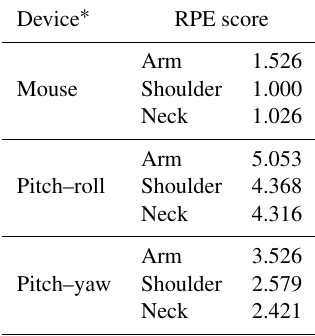
Table 5. Qualitative result. Assessment